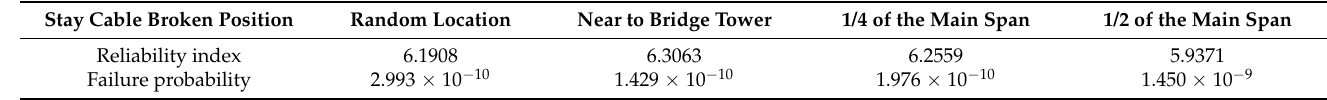
Table 10. Static wind instability probability corresponding to different broken cable